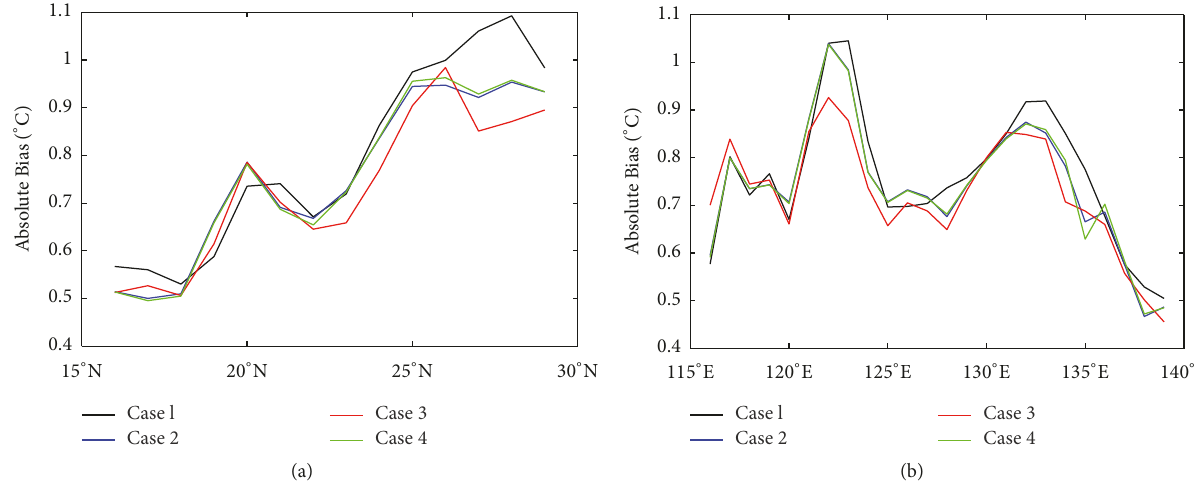
Figure 8: Mean difference averaged zonally (a) and meridionally (b) over the whole depth of cases 1–4: here the absolute difference is applied.